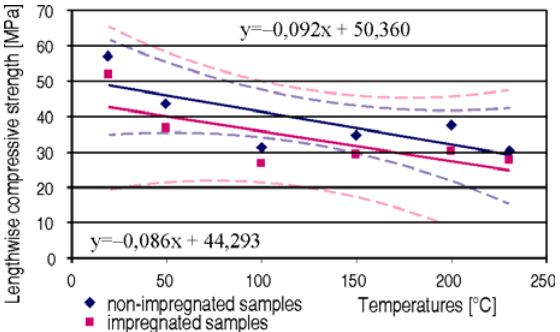
Fig 8. Lengthwise compressive strength vs temperature for impregnated and non-impregnated wood